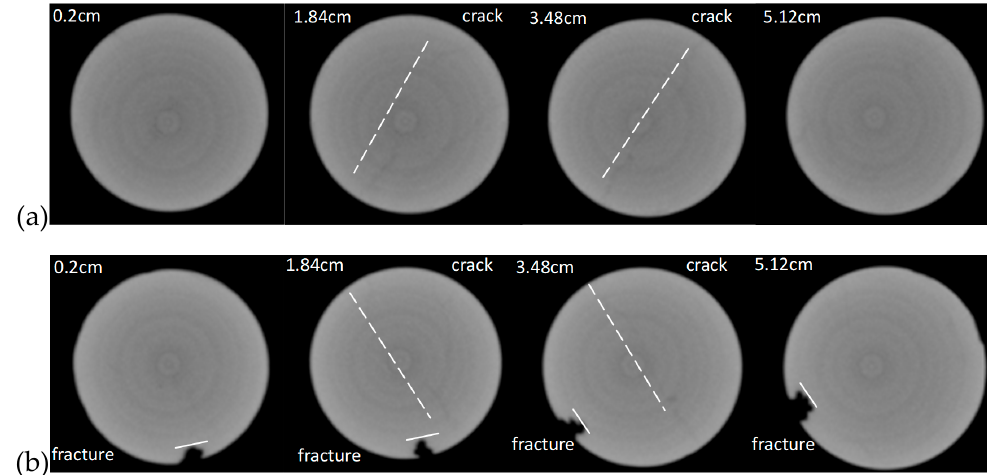
Figure 10. Industrial CT scanning on sample 13: ( a ) before and ( b ) after acid fracturing.